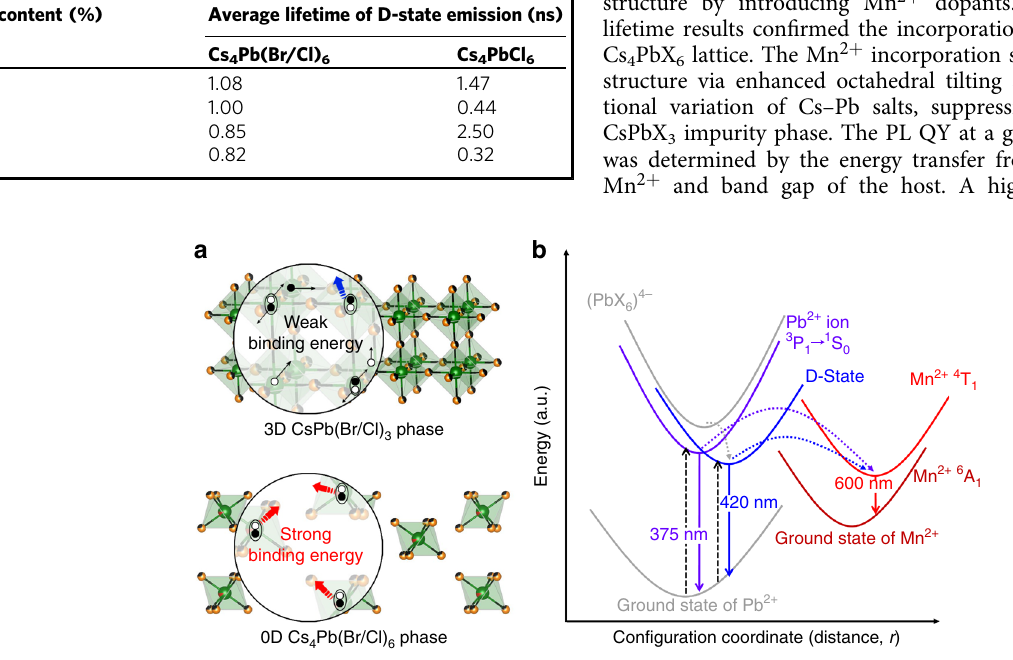
Fig. 5 Mechanism of energy transfer from host states to Mn 2 + . a Illustration of high exciton binding energy (at above 150 meV) due to the localized excitons formed in the isolated octahedra of 0D Cs 4 PbX 6 (X = Cl, Br/Cl) perovskite, compared to low binding energies (less than 60 meV) of 3D CsPbX 3 perovskite, where fi lled and hollow circles represent electrons and holes, respectively. b Con fi gurational coordinate representation of Cs 4 Pb(Br/Cl) 6 perovskite depicting Pb 2 + -based ( 3 P 0,1 → 1 S 0 transition) and D-state emissions, and their energy transfer to the Mn 2 + energy levels. The long dash and dotted arrows depicts the excitation and energy transfer process leading to emission (solid